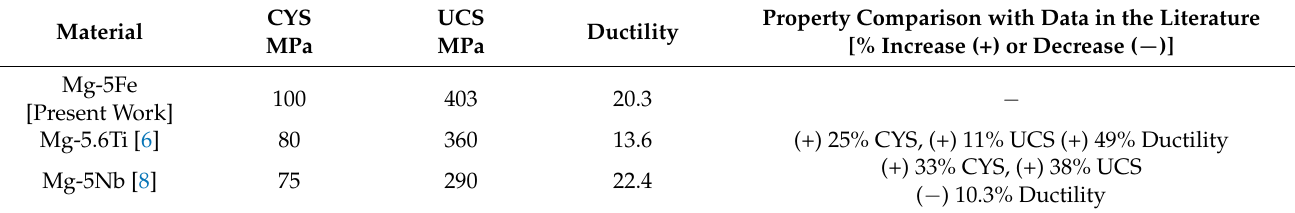
Property Comparison with Data in the